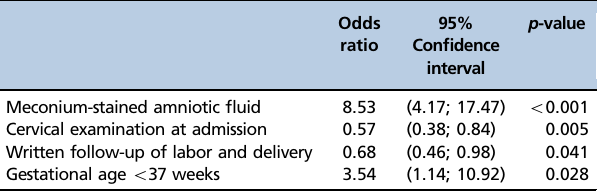
Table 5 - Variables associated with the use of positive-pressure